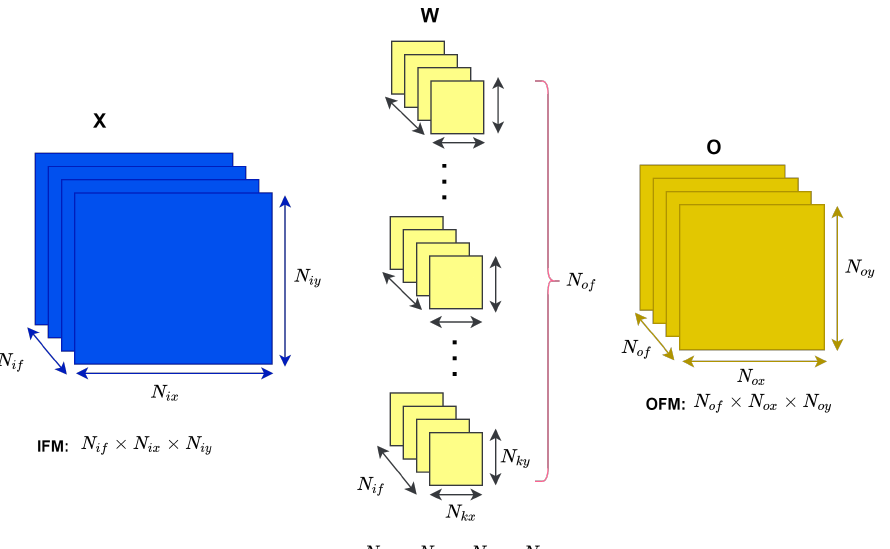
Figure 2. Feature maps and weight tensors representation of a particular convolution layer. Although not indicated in the figure, usually convolution layers have also learned bias (B) parameters of size equal to the number of output channels, that is N of . That is one bias value per output